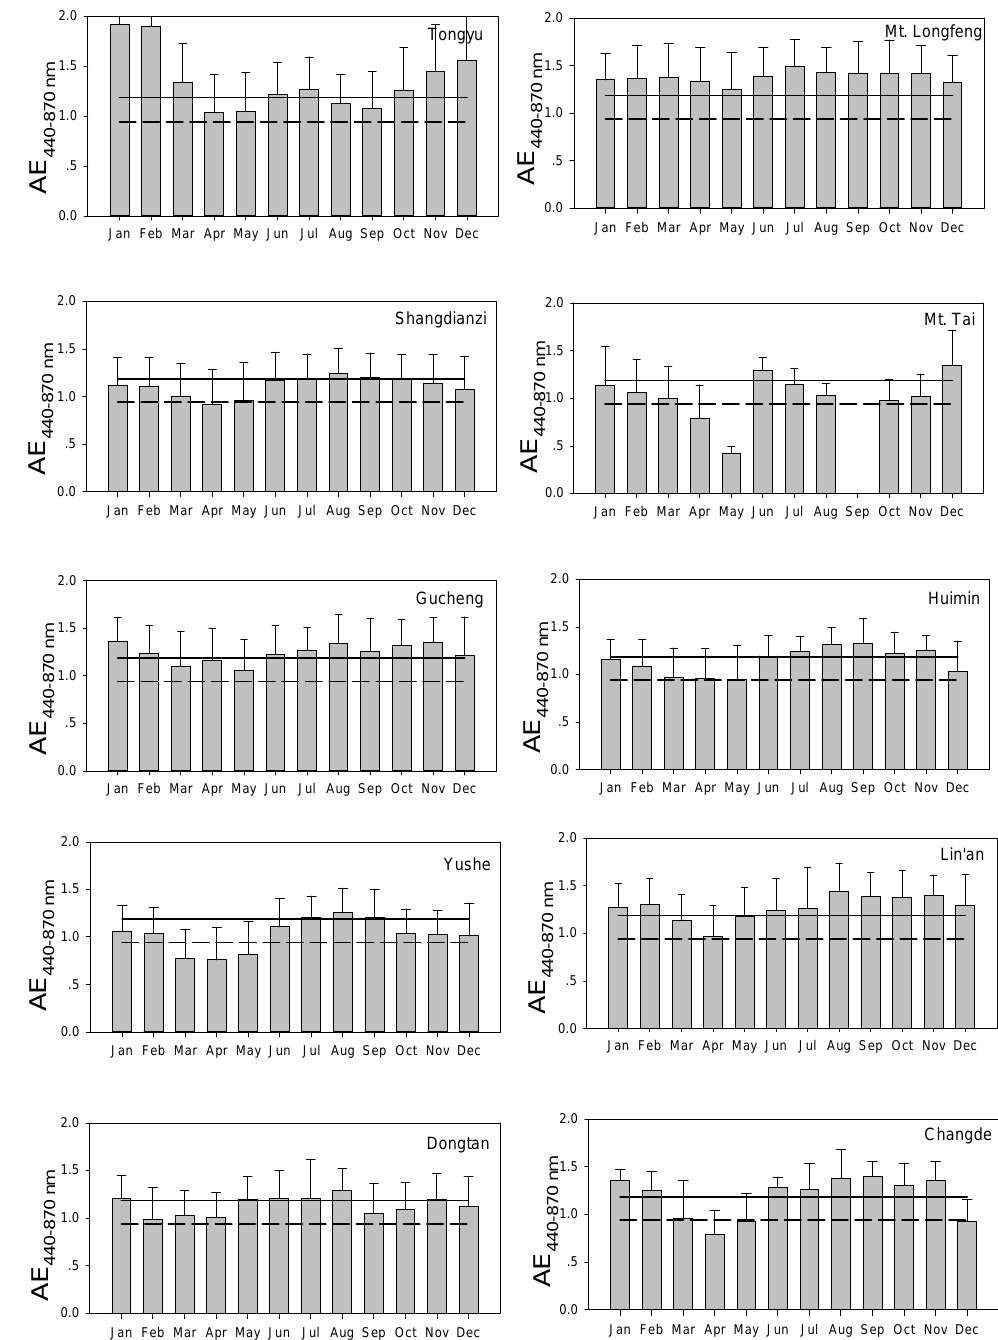
Figure 13. Monthly averaged AEs between 440 and 870nm at rural central and eastern China sites. The solid and dash horizontal hairlines indicate the annual averages for the subgroup and the whole database,